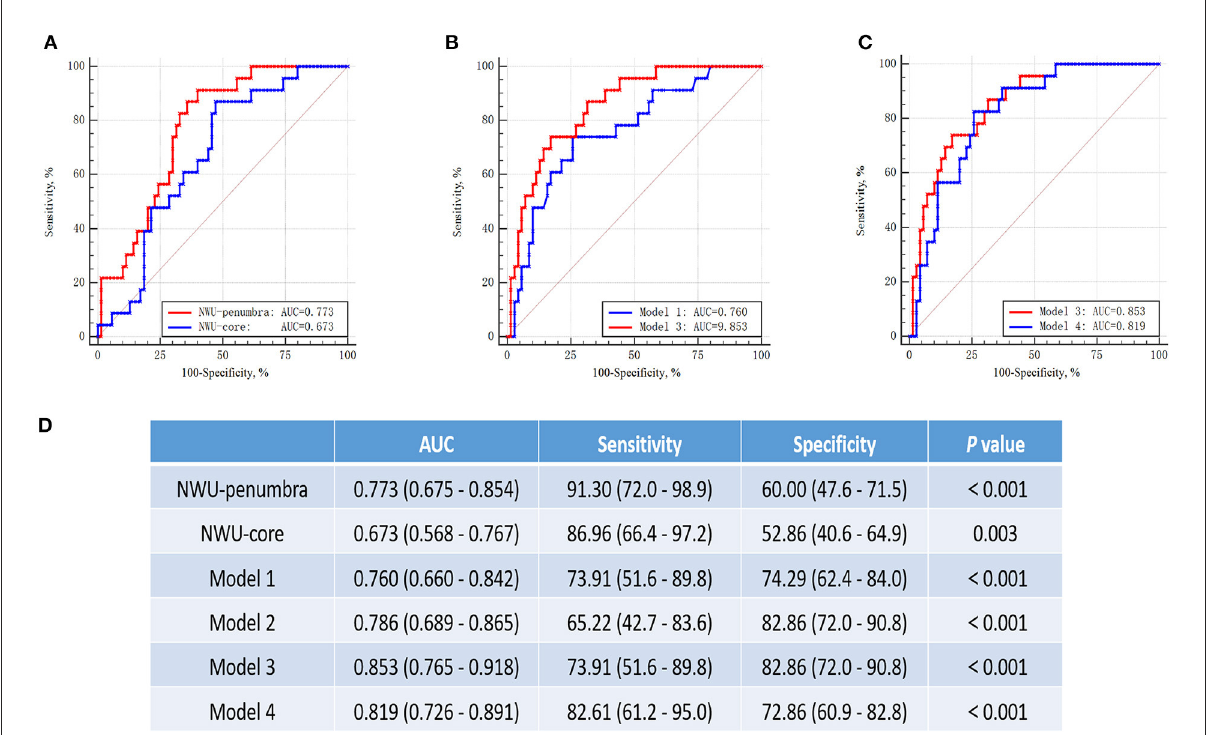
FIGURE3 ROC curves for prediction of sICH in patients with mechanical thrombectomy. (A) The ROC curves of NWU-penumbra vs. NWU-core (AUC: 0.773 vs. 0.673). (B) The ROC curves of model 1 vs. model 3 (AUC: 0.760 vs. 0.853). (C) The curves of model 3 vs. model 4 (AUC: 0.853 vs. 0.812). (D) Table showed the data of ROC curve